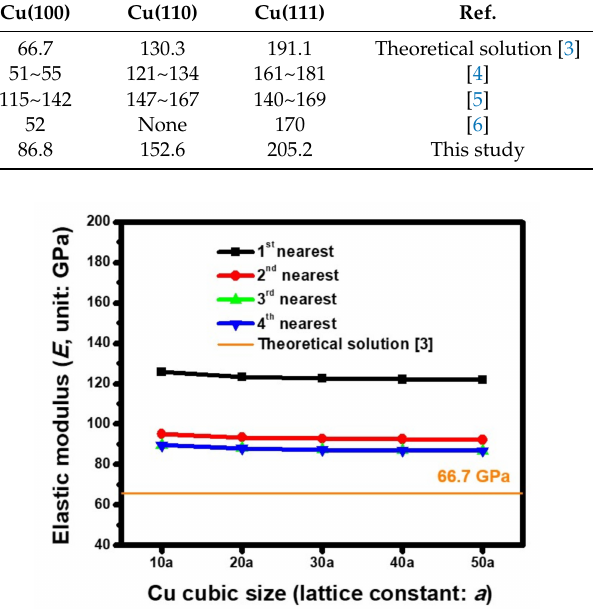
Figure 5. Size-dependent E of the Cu(100) crystal cube estimated by using the Morse parameters of